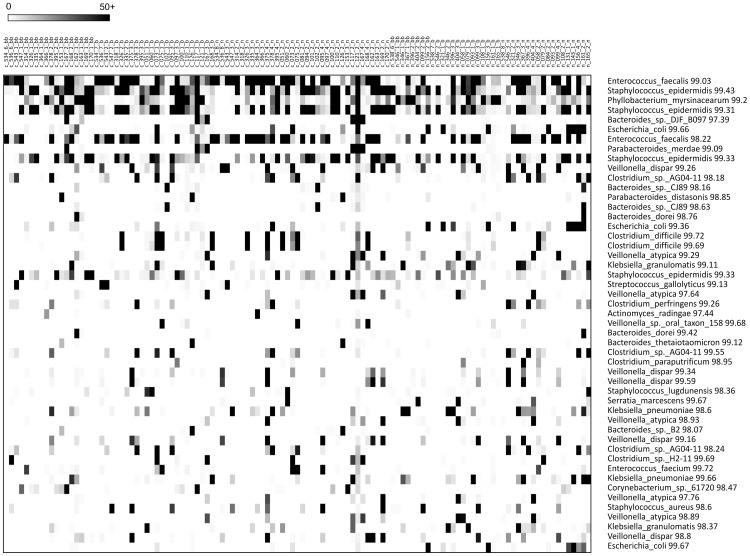
Dominant OTU's.Each row represents a separate OTU with the closest match in the database listed on the right. Each column represents an individual sample from both cases and controls at each of the three time points. OTUs are listed in order of dominance with the most dominant on the top. Darker color indicates higher number of sequences in this OTU in an individual sample (see color code in left corner). Darkest shade indicates 50+ sequence reads obtain for that OTU in that sample.